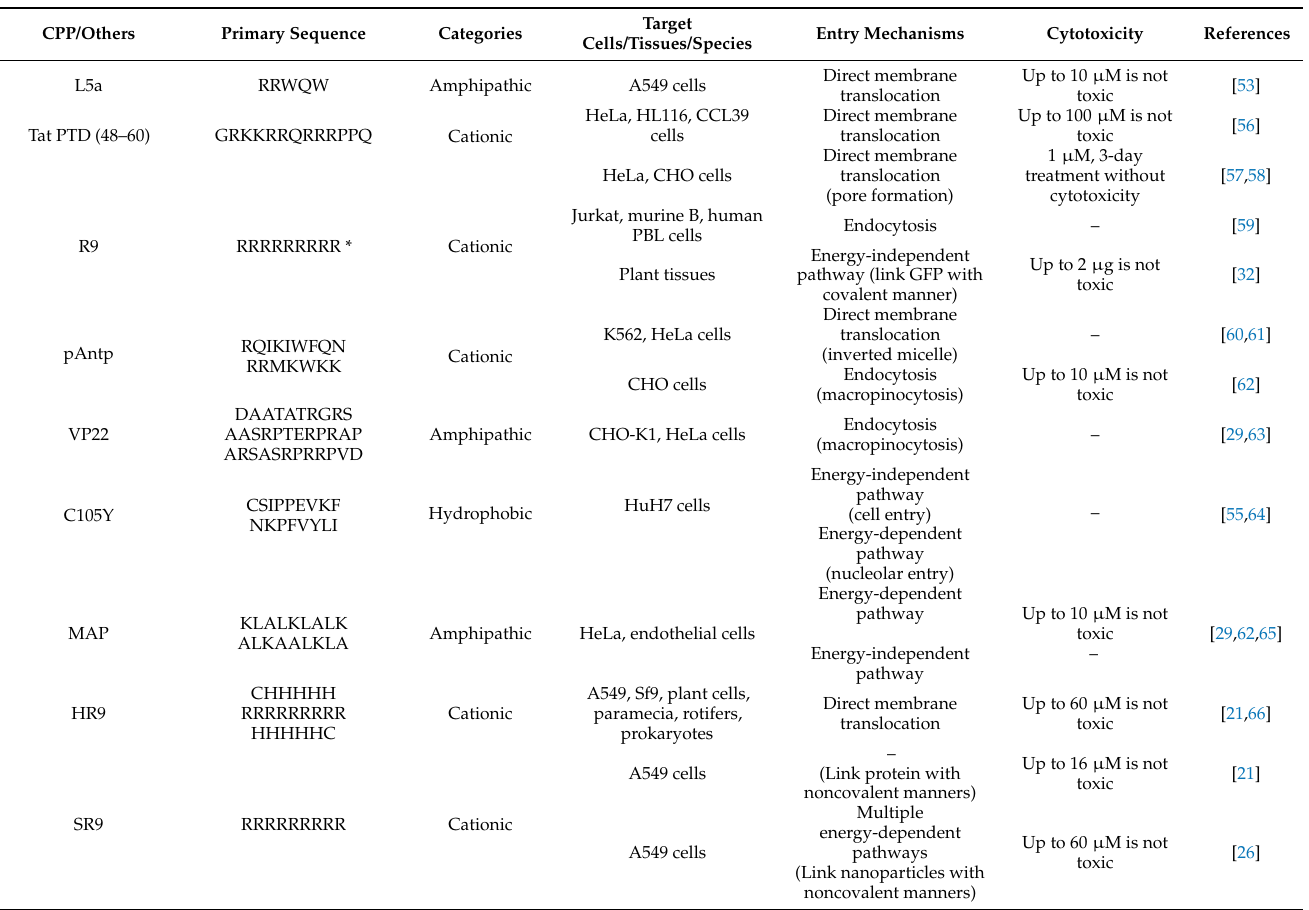
Table 1. Comprehensive information of major cell-penetrating peptides and